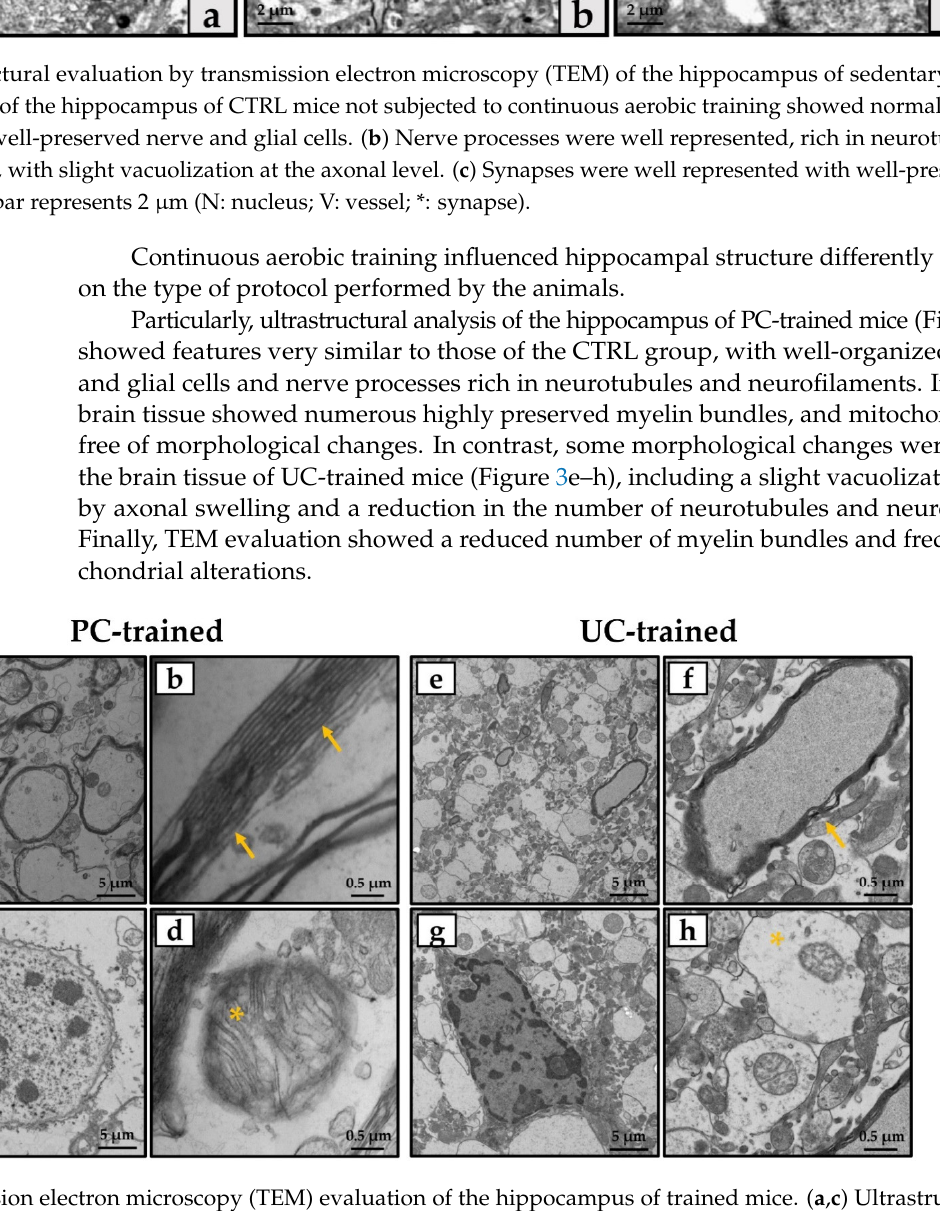
Figure 3. Transmission electron microscopy (TEM) evaluation of the hippocampus of trained mice. ( a , c ) Ultrastructural analysis of the hippocampus of PC-trained mice showed well-preserved tissue organization, with well-organized neuronal and glial cells and nerve processes rich in neurotubules and neurofilaments. ( b , d ) Numerous highly preserved myelin bundles (arrows) and mitochondria without morphological changes (asterisk) were observed. ( e , g ) Ultrastructural analysis of the hippocampus of UC-trained mice showed some morphological changes, such as slight vacuolization at the axonal level and few neurotubules and neurofilaments. ( f , h ) A reduced number of myelin bundles (arrow) and frequent mitochondrial alteration (asterisk) were detected. Scale bars represent 5 or 0.5 μ m.